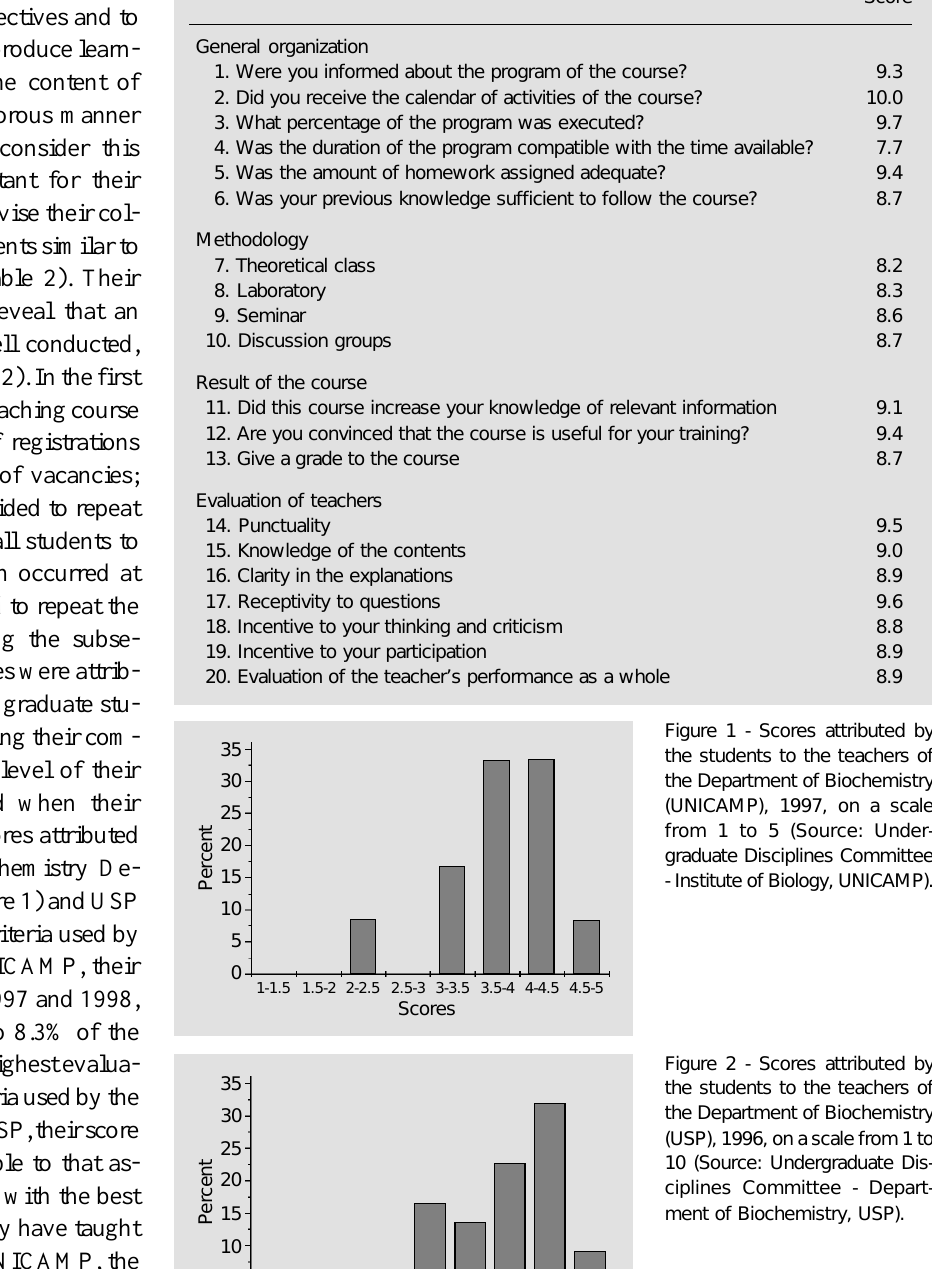
Figure 2 - Scores attributed by the students to the teachers